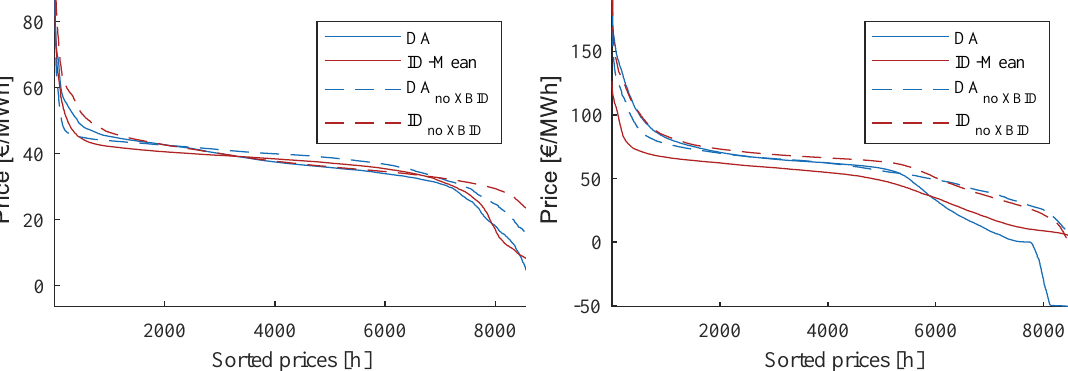
Figure 16. Price duration curve with and without XBID for the German market in 2023 ( left ) and 2035 ( right